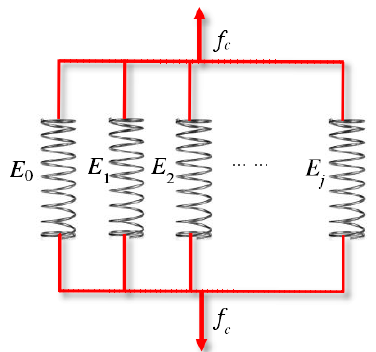
Figure 10. Schematic diagram of Voigt’s parallel model.